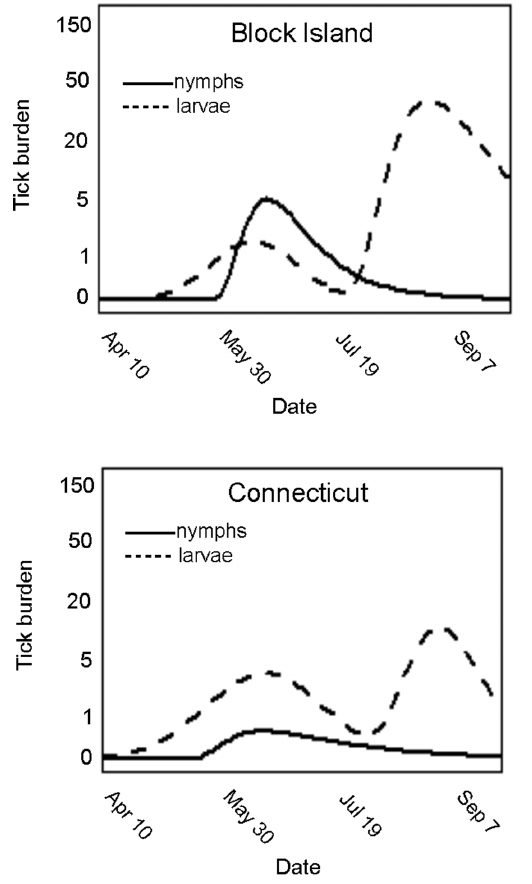
Fig 4. Larval and nymphal tick burdens on Peromyscus leucopus expressed as mean tick count per mouse. Tick burdens are presented as best fit curves to field derived data from Block Island, RI (top) and Connecticut (bottom) sampled populations (S2